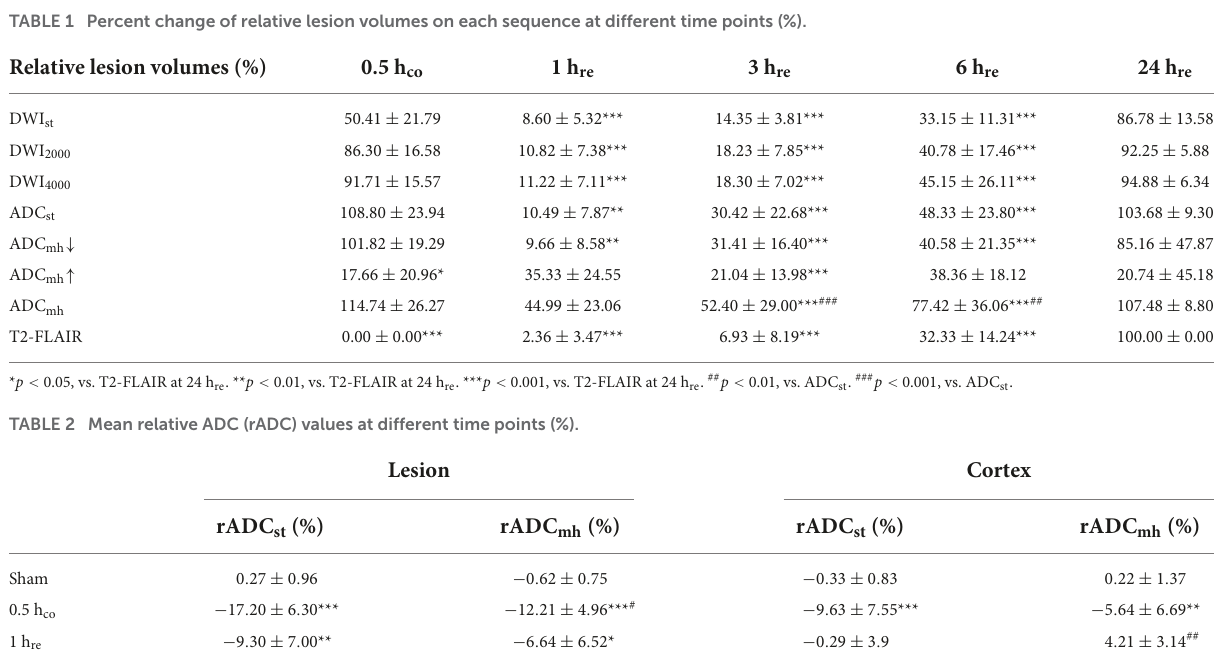
TABLE 1 Percent change of relative lesion volumes on each sequence at different time points (%). Relative lesion volumes (%)